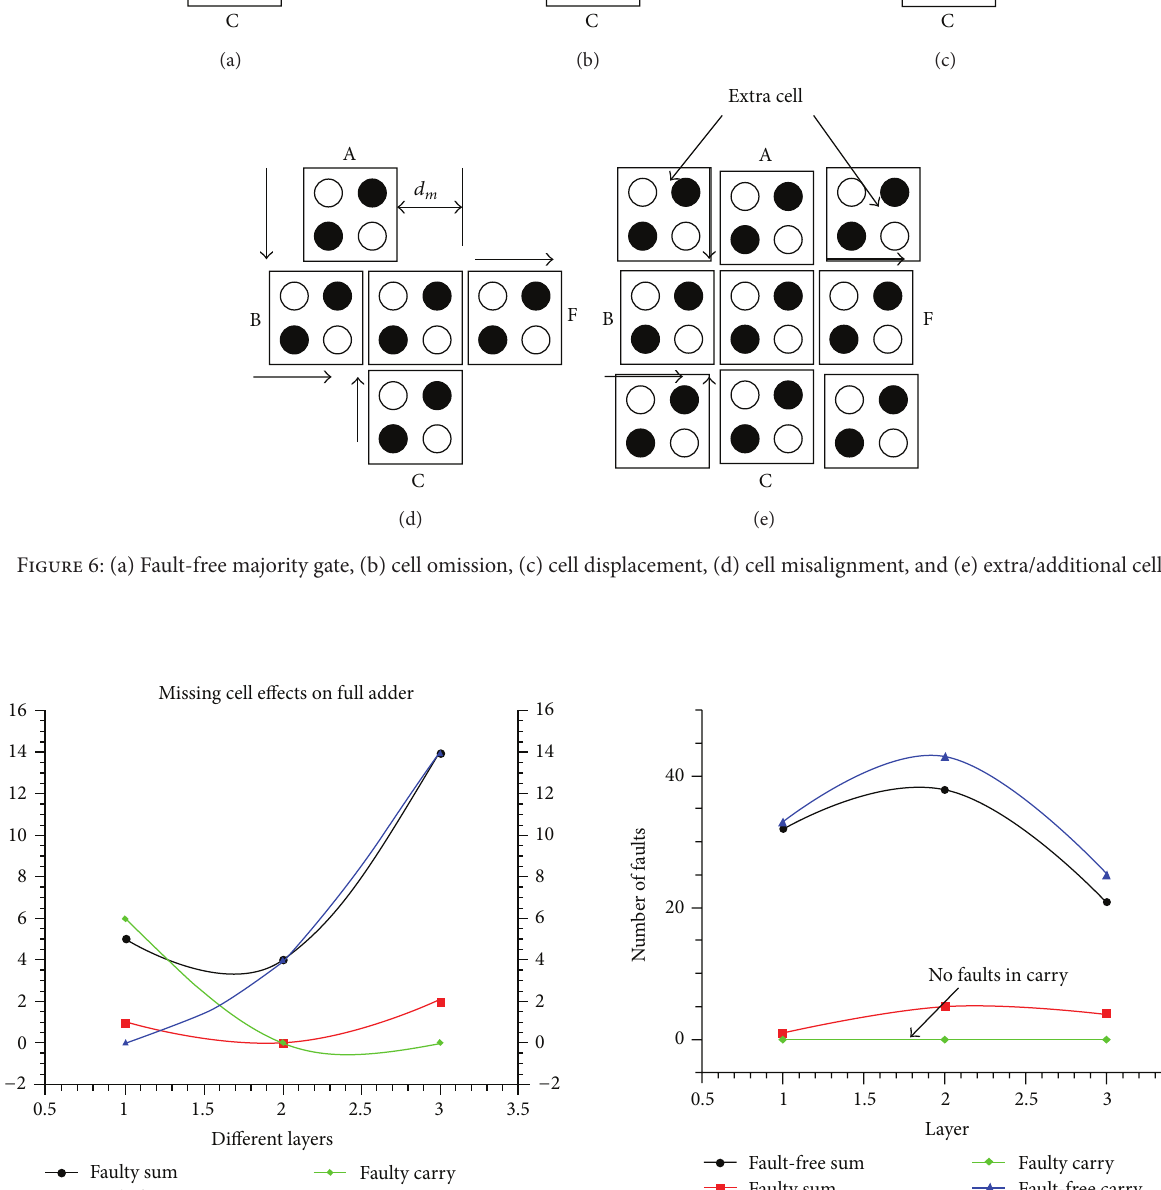
Figure 7: Missing cell defect. Figure 8: Additional cell